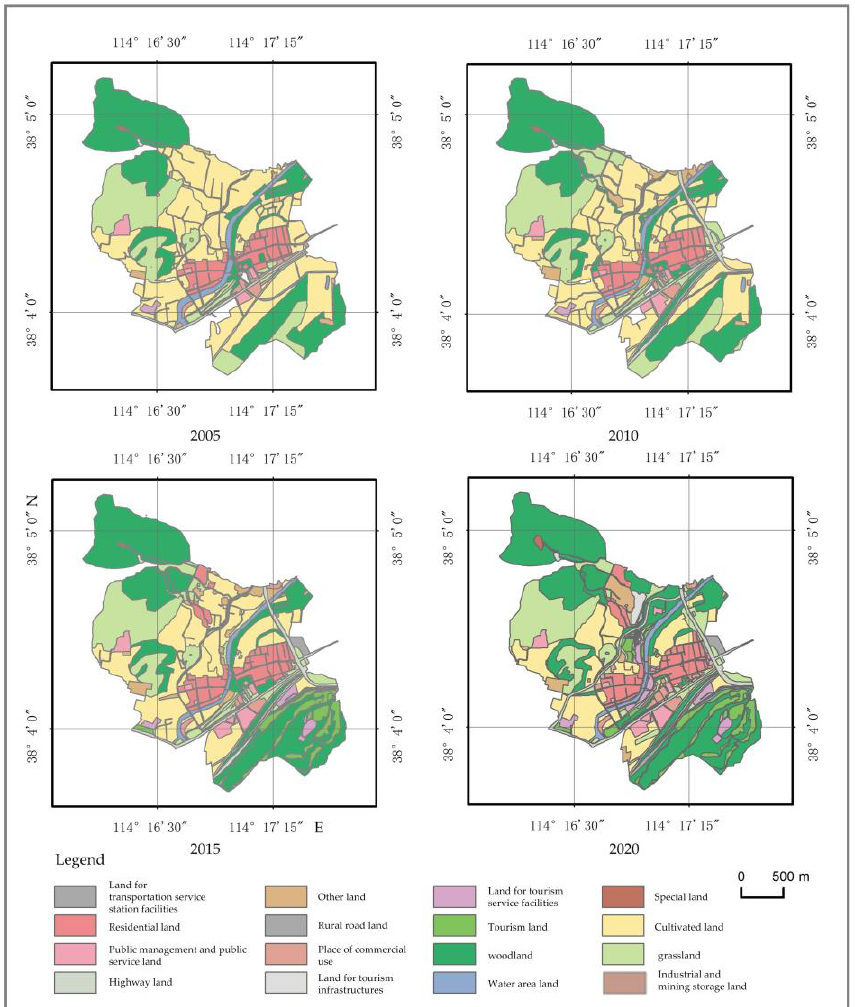
Figure 2. The current land use situation of East Tumen Village and West Tumen Village from 2005 to